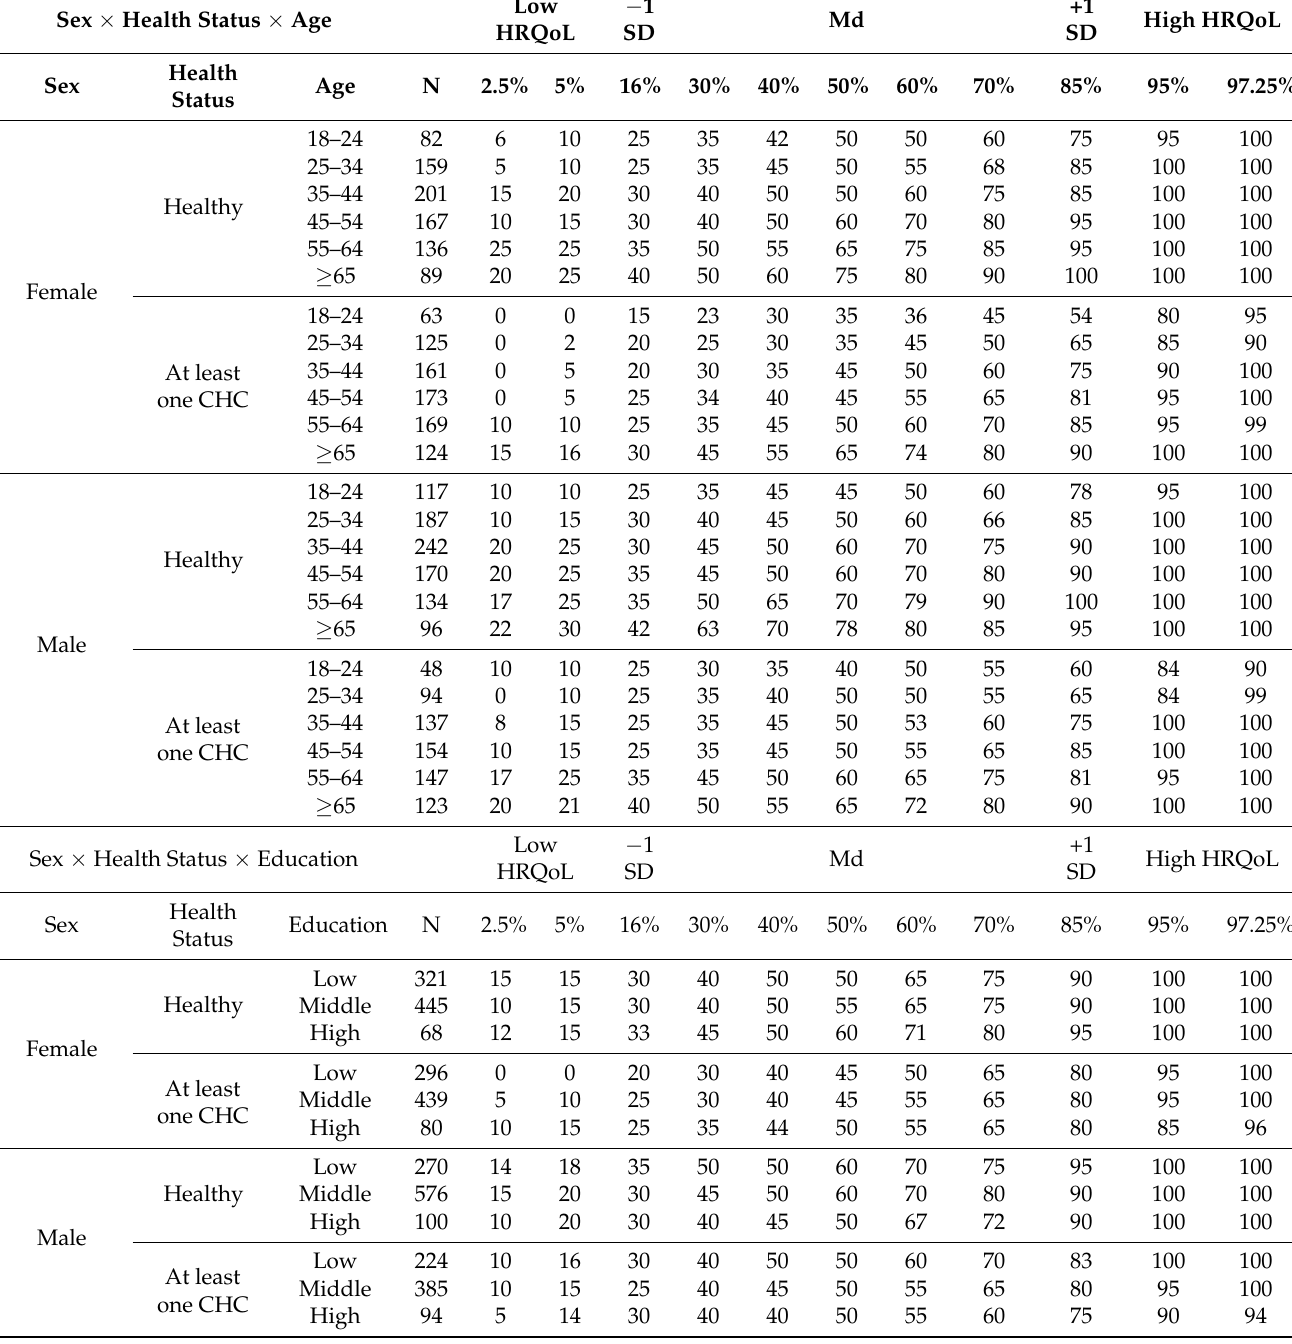
Table A8. Reference values for the QOLIBRI Emotions scale obtained from the general population sample in Italy stratified by sex, health status, age, and